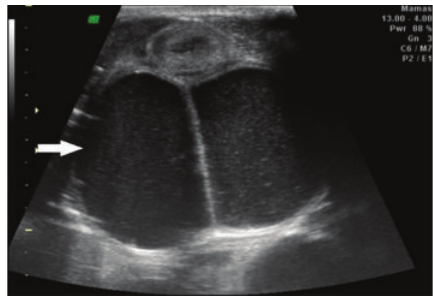
Figure 2: Ultrasound scan after the bladder was completely empty, shows the septated cystic mass (white arrow) occupying the region of the newborn’s